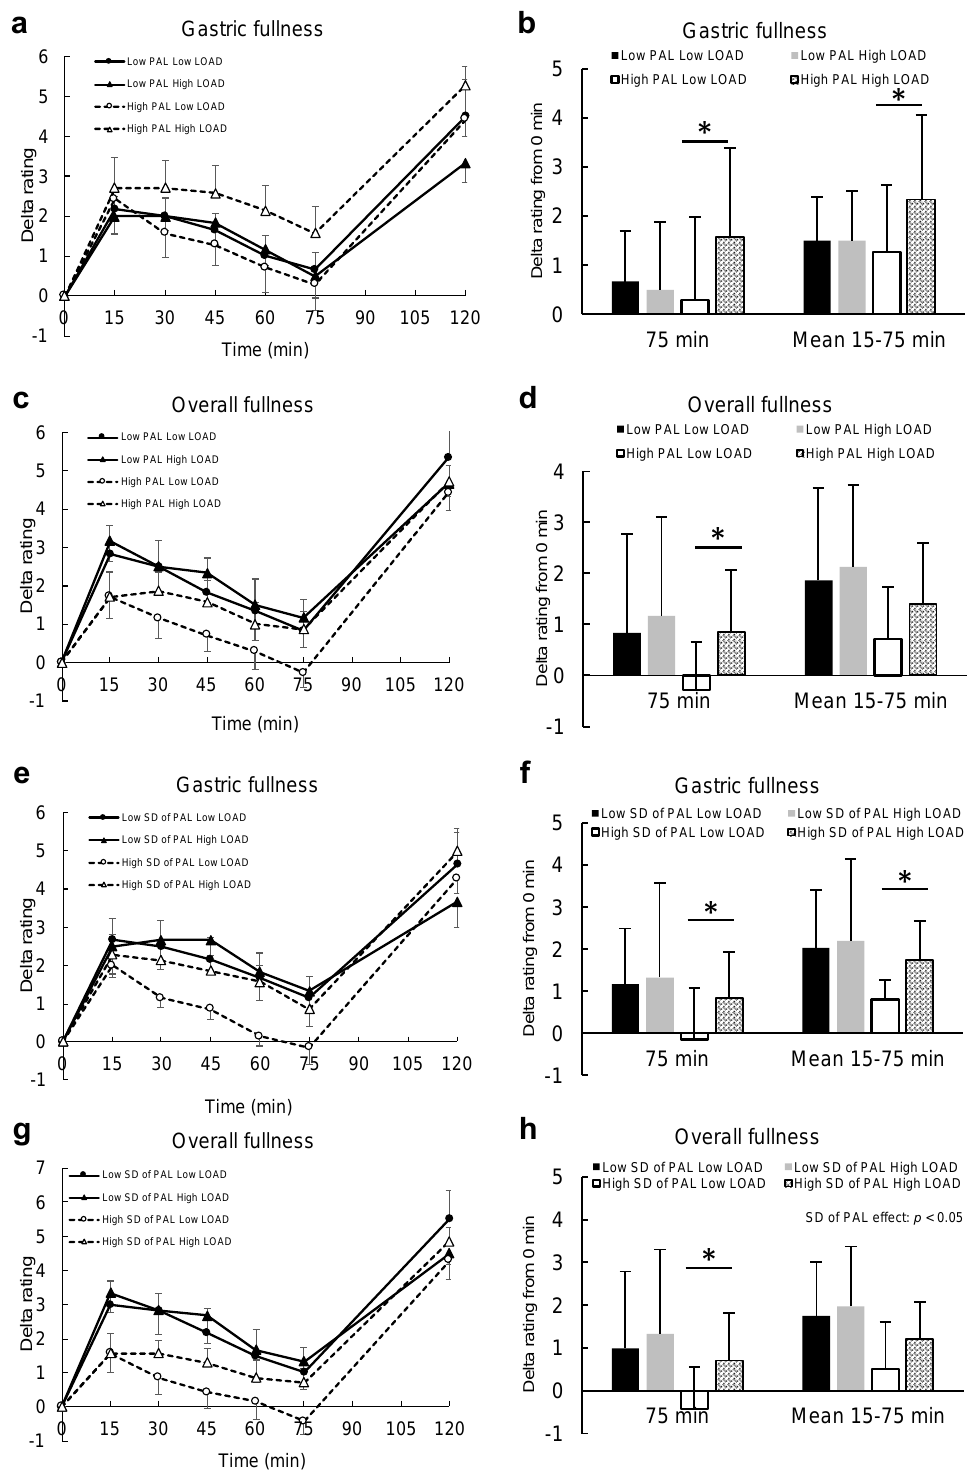
Figure 4. Results of various fullness variables after energy load. ( a ), ( c ), ( e ), ( g ) Trajectories of fullness variables following energy load in individuals with high or low PAL or SD of PAL. ( b ), ( d ), ( f ), ( h ) Mean values of the fullness variables at 75 min after energy load and during 15–75 min after energy load in individuals with high or low PAL or SD of PAL (mean ± SD). Legend: LOAD, energy load; PAL, physical activity level. * p < 0.05. Error bars for ( a ), ( c ), ( e ), and ( g ) show standard error. Error bars for ( b ), ( d ), ( f ), ( h ) show standard deviation.